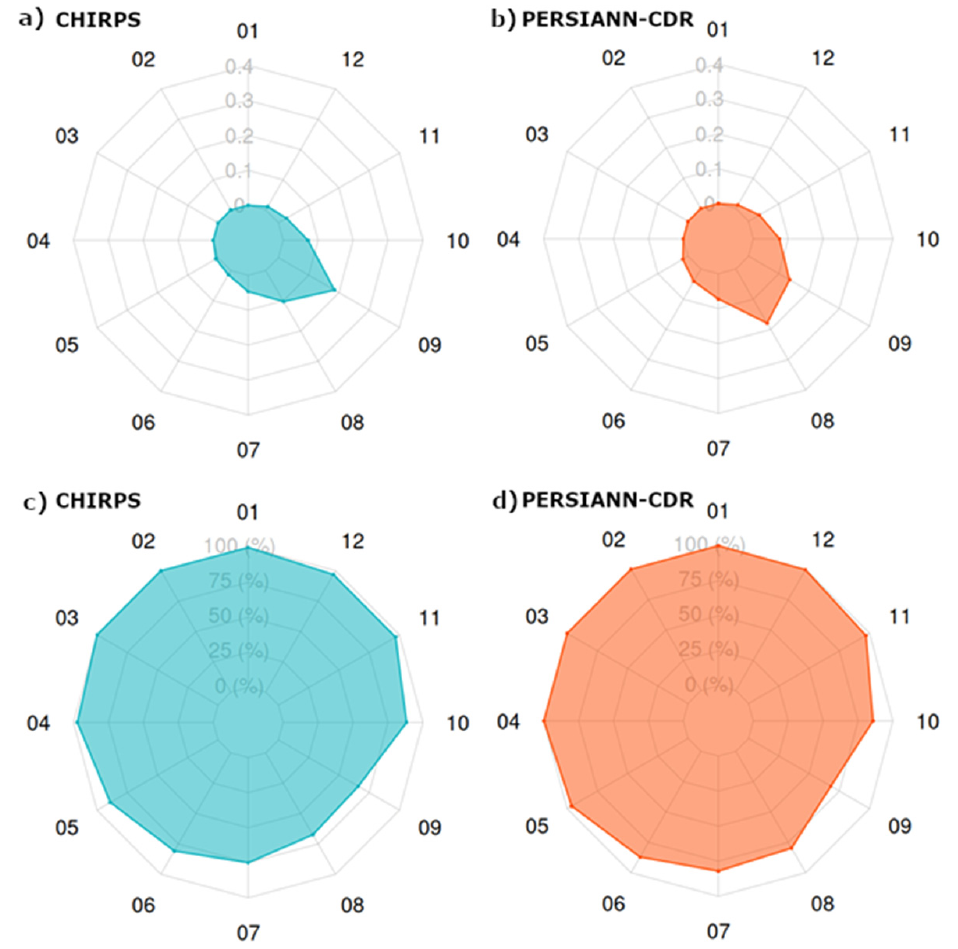
Figure 9. False alarm ( a —CHIRPS and b —PERSIANN-CDR) and probability of occurrence ( c —CHIRPS, d —PERSIANN-CDR) of the monthly mean (gridBR × RES) from January (01) to December (12) 1983 to 2013.